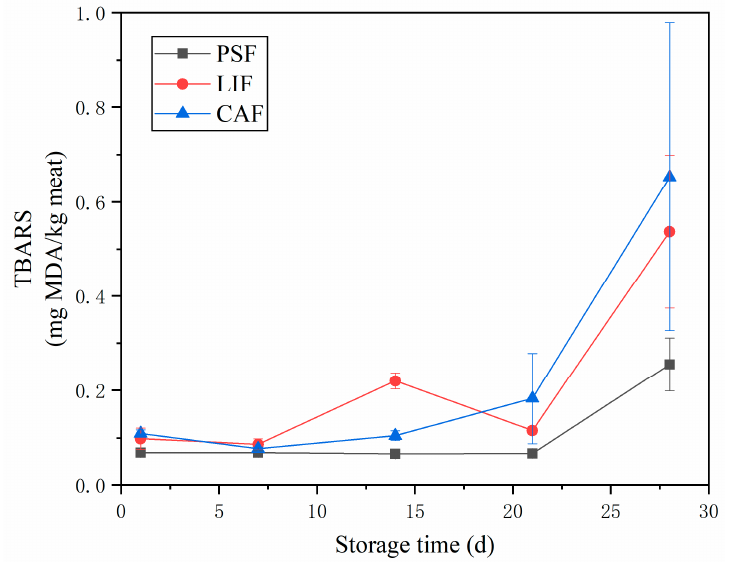
Figure 3. TBARS changes for largemouth bass during frozen storage with different freezing methods.